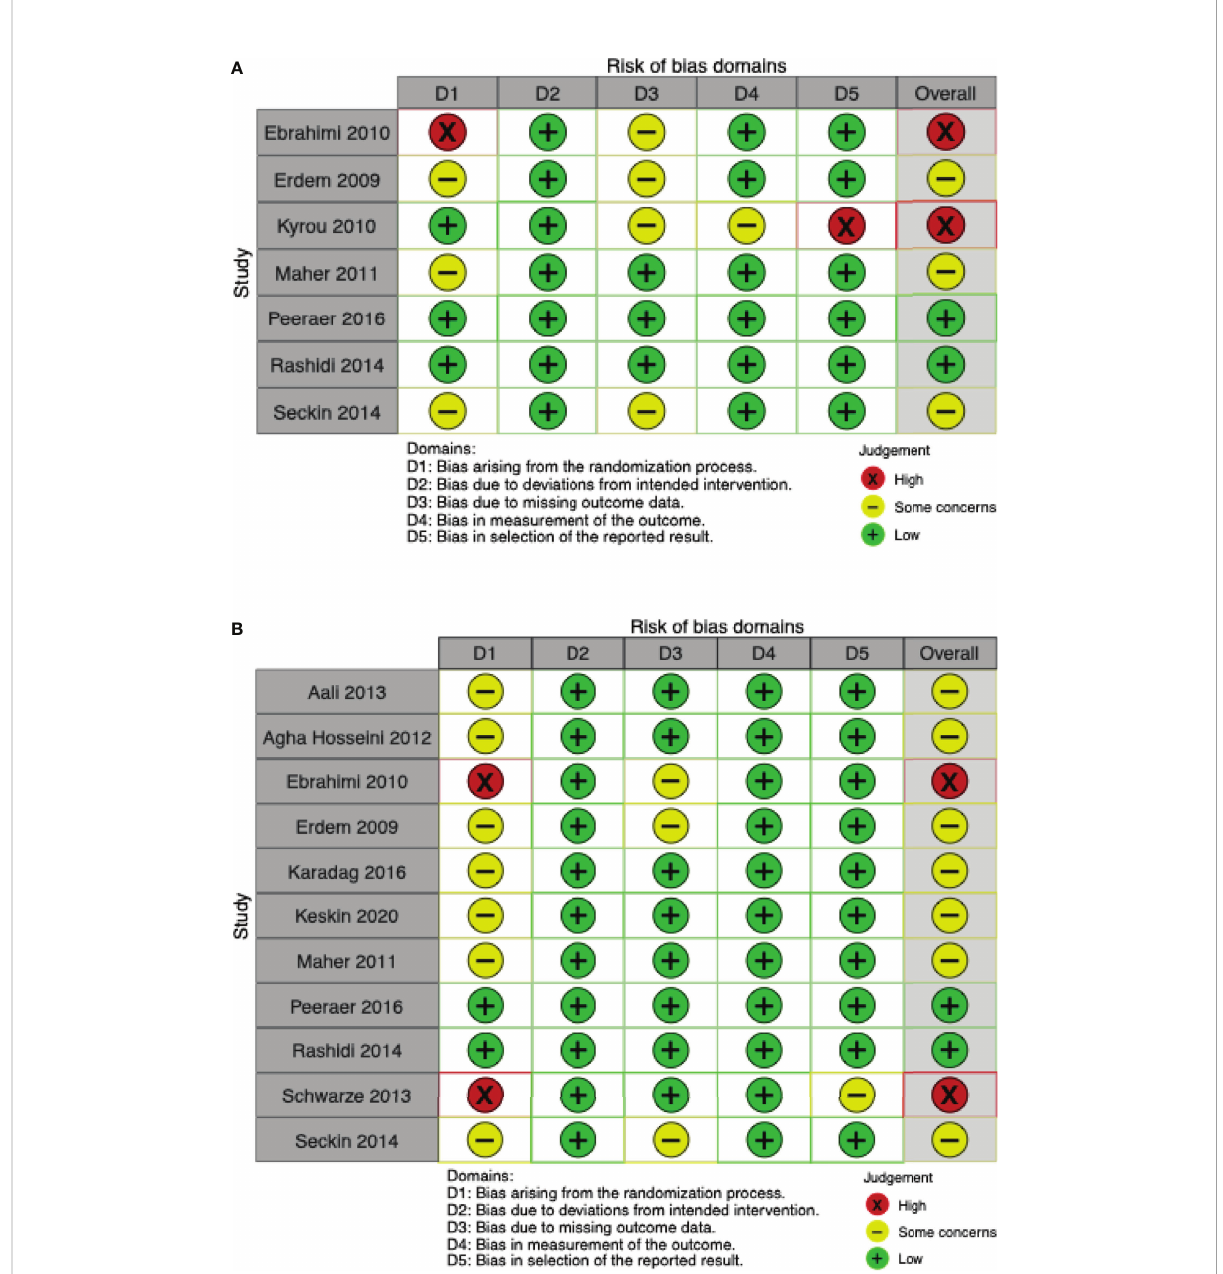
FIGURE 2 Risk of bias ‘ traf fi c-lights ’ plots for the studies included in meta-analysis. (A) Live birth. (B) Clinical